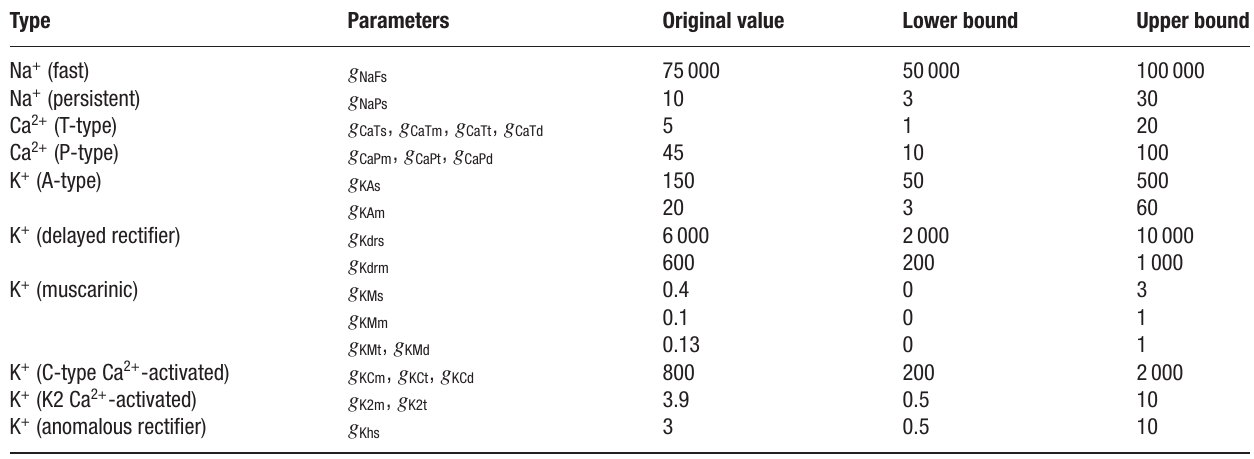
Table 1 .The 24 maximal conductance parameters of the PC model that were tuned in